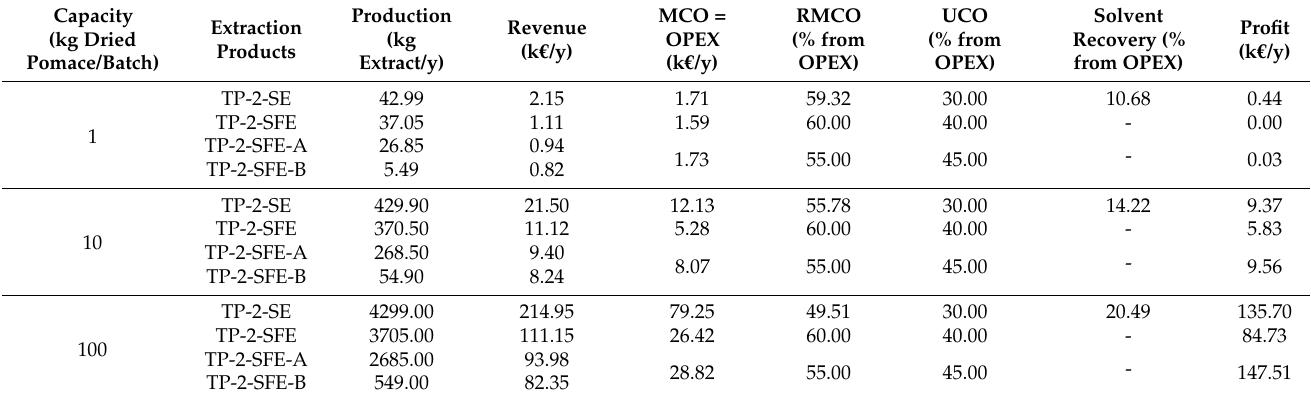
Table 7. Estimated values for annual manufacturing cost components.